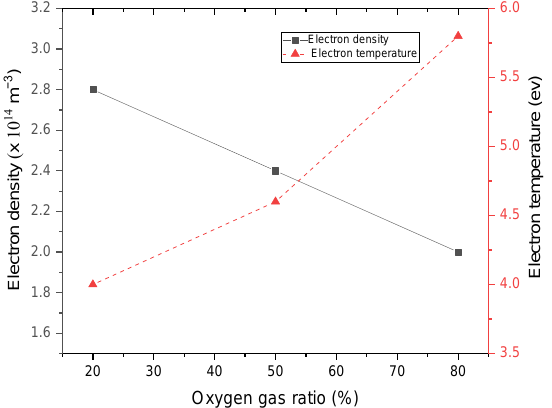
Figure 12. Density and temperature of electrons in Ar/O 2 mixture for different O 2 percentages at 0.3 Torr total gas pressure and RF voltage (150 V, 13.56 MHz).